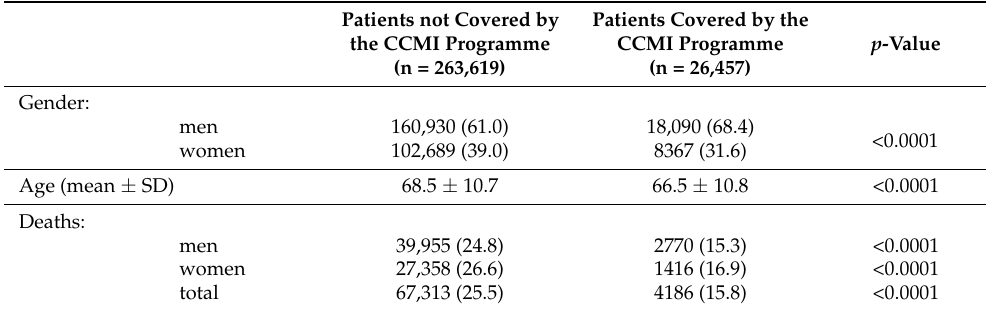
Table 1. Demographic characteristics and number of deaths within 365 days of the first hospitalisation in the patients not covered and covered by CCMI. Descriptive data are presented as number of observations (percentage) or mean ± standard deviation ( ±